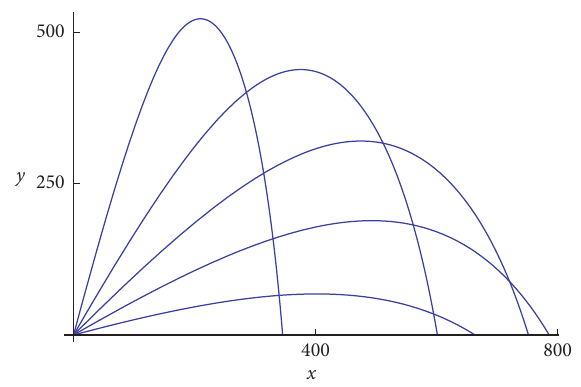
Figure 1: Flight trajectories under air